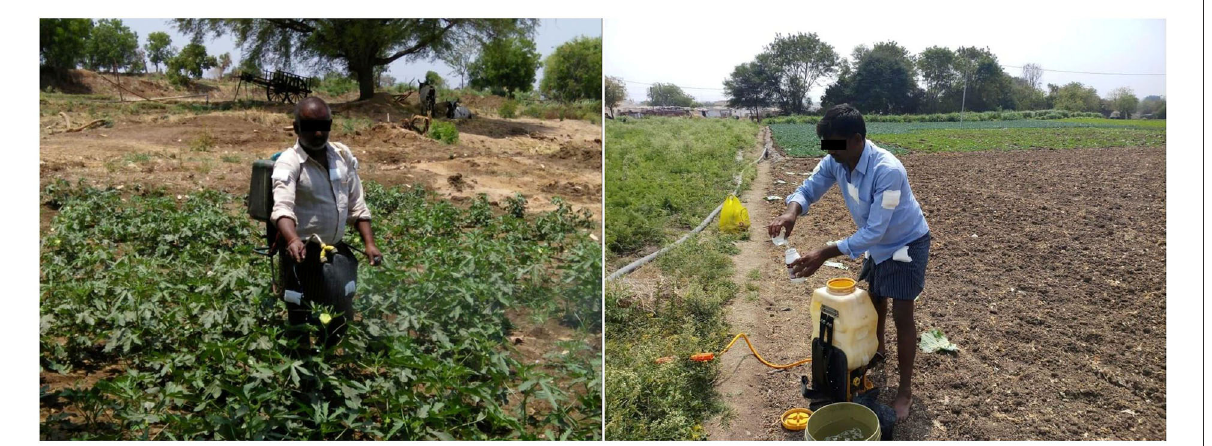
FIGURE2 Operators mixing and spraying pesticides without following any safety protocol.